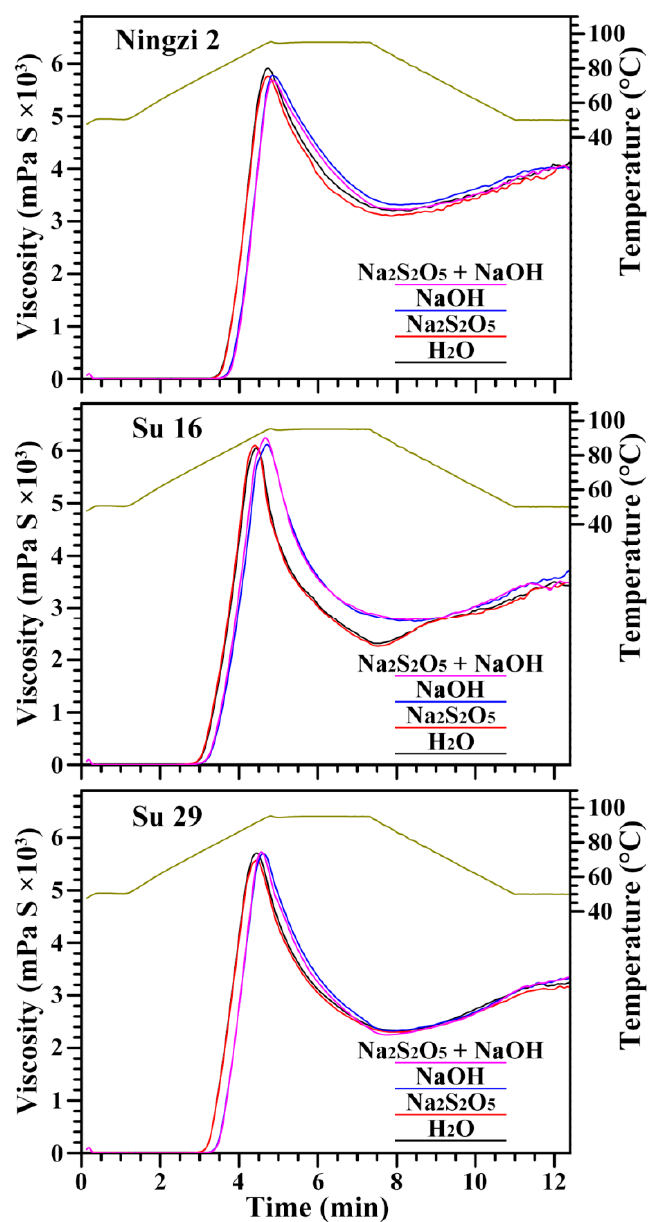
Figure 8. Pasting profiles of starches. Table 6. Pasting parameters of starches.